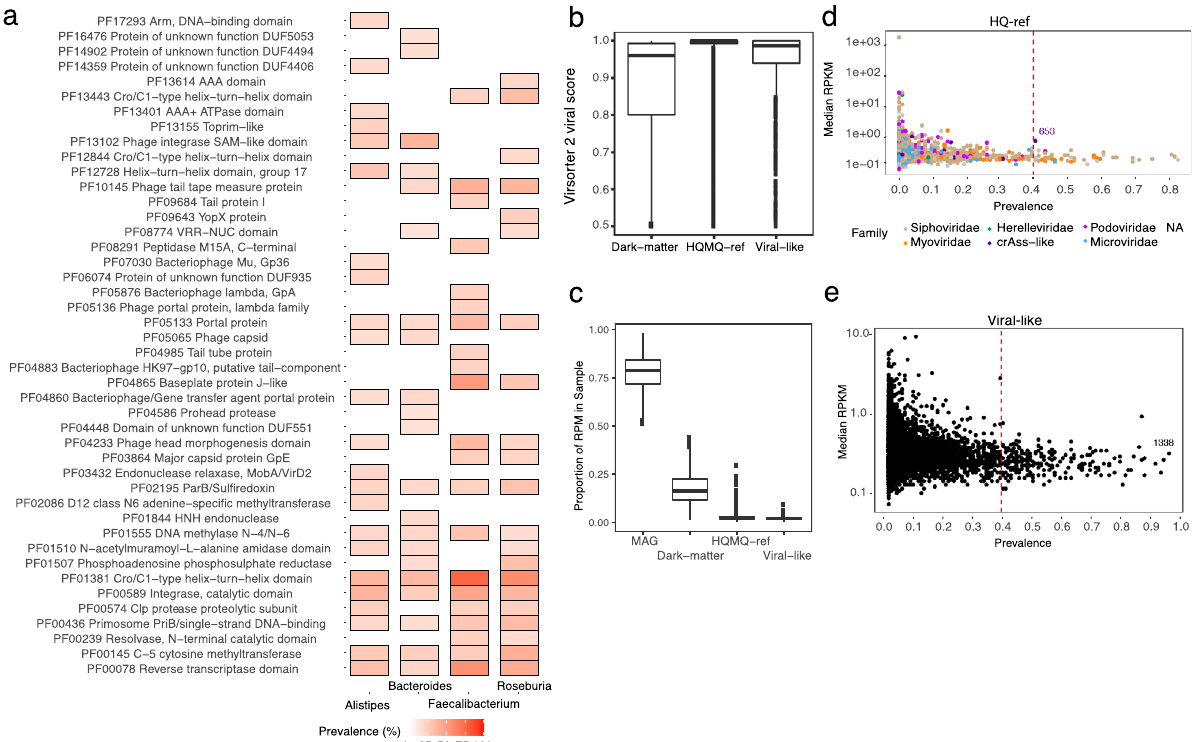
Fig. 6 Viral proteins and the dark-matter metavirome. a The percentage of HQ viruses, associated with four bacterial host genera; Alistipes, Bacteroides, Faecalibacterium and Roseburia, which encode top-20 prevalent PFAM domains. b Virsorter2 viral prediction scores for all viral bins with at least one viral hallmark gene. Completeness was estimated using CheckV and the bins were grouped as (1) HQ-MQ-ref when completeness ≥ 50% or high-quality ≥ 90% ( n = 45,983 bins), (2) bins with less than 50% completeness were annotated as Dark-matter ( n = 392,226 bins), and (3) dark-matter bins with con fi dent CRISPR spacers against a bacterial host were annotated as Viral-like ( n = 43,695 bins). c The distribution of sample RPM of bacterial MAGs, HQ-MQ-ref viral populations, Dark-matter and Viral-like populations as de fi ned in ( b ). The majority of sample reads were mapped to MAGs but on average 17.7% of all reads mapped to Dark-matter bins. d The abundance in RPKM of rare and highly prevalent viruses with an HQ genome in HMP2. Each point represents a viral population coloured according to the viral taxonomic family. The progenitor-crAssphage is indicated as cluster 653. e As in ( d ) but with viral-like populations like cluster 1338 showing that many are low abundant, but highly prevalent. RPM read per million, RPKM read per kilobase